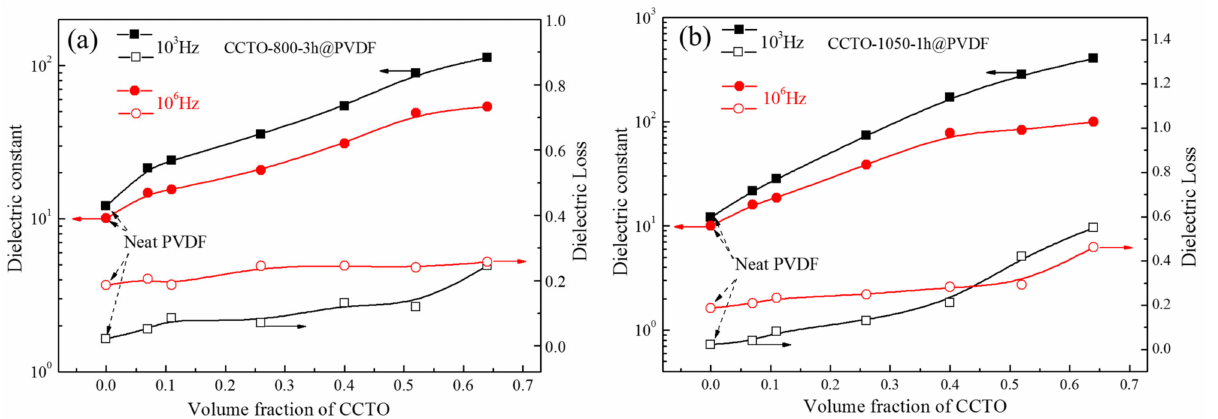
Figure 10. Dielectric properties at 1 kHz and 1 MHz of composites ( a ) CCTO-800-3 h@PVDF and ( b ) CCTO1050-1 h @PVDF at different filler contents.